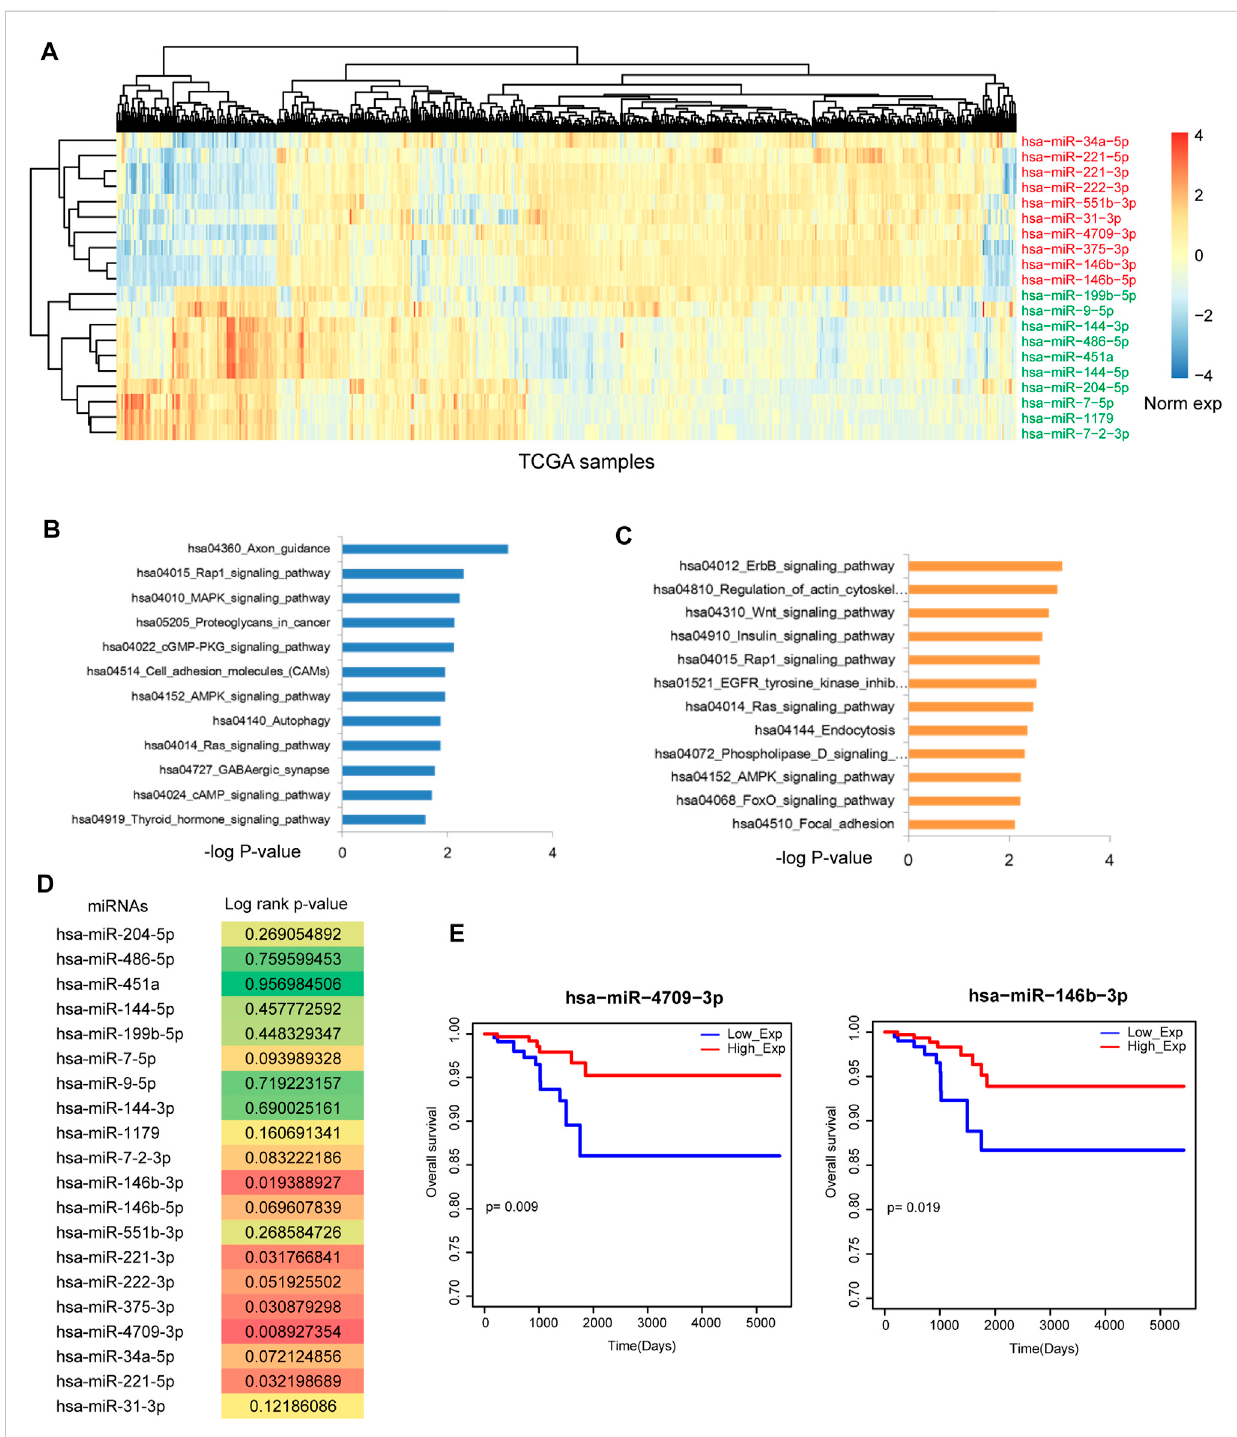
FIGURE 1 Identi fi cation of the potential prognosis biomarker of THCA. (A) The heat map of the most upregulated 10 miRNAs and the most downregulated 10 miRNAs. (B) Pathway enrichment of the most upregulated 10 miRNAs. (C) Pathway enrichment of the most downregulated 10 miRNAs. (D) The log- rank p -valuesofthe20mostDEmiRNAs.MultiplemiRNAswerestatisticallysigni fi cantwith p < 0.05. (E) TheKaplan-Meiersurvivalcurvesof miR-4709-3p and miR-146b-3p .